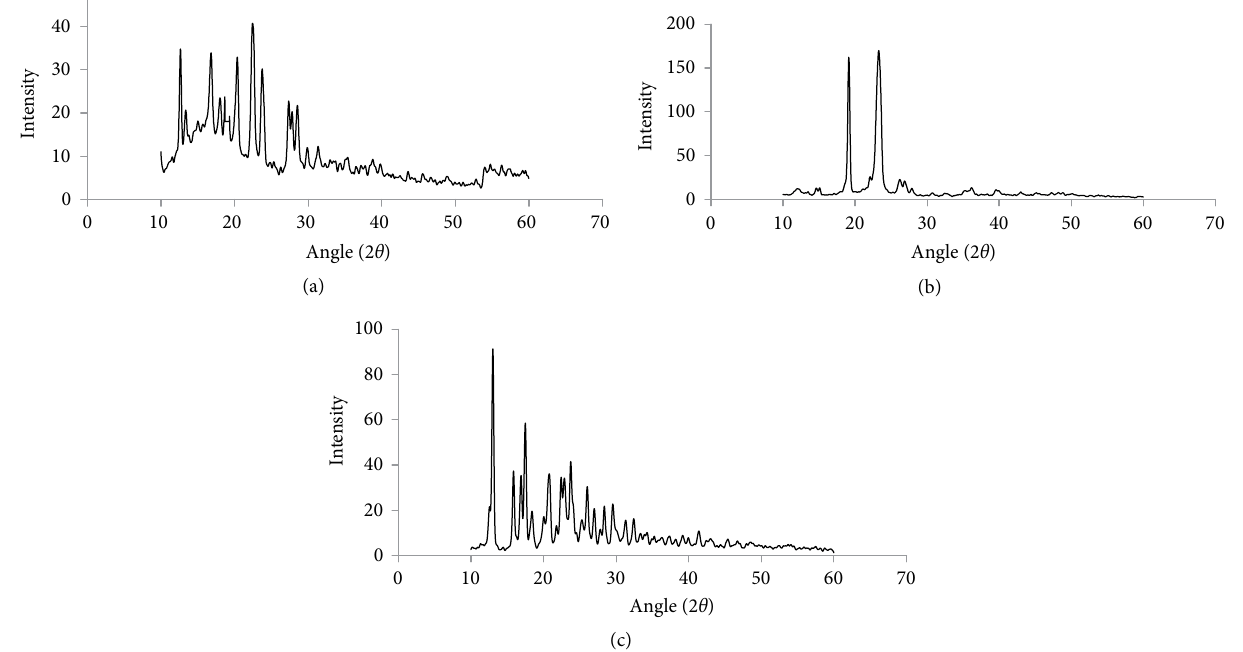
Figure 7: (a) XRD pattern of drug loaded PEG-g-poly (MAA) nanogels. (b) XRD pattern of PEG-6000. (c) XRD pattern of naproxen